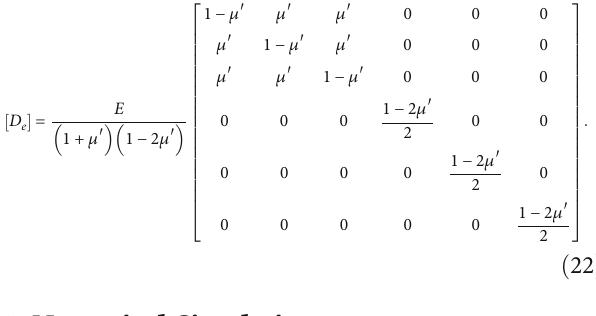
Figure 2: Distribution of coal stratum and